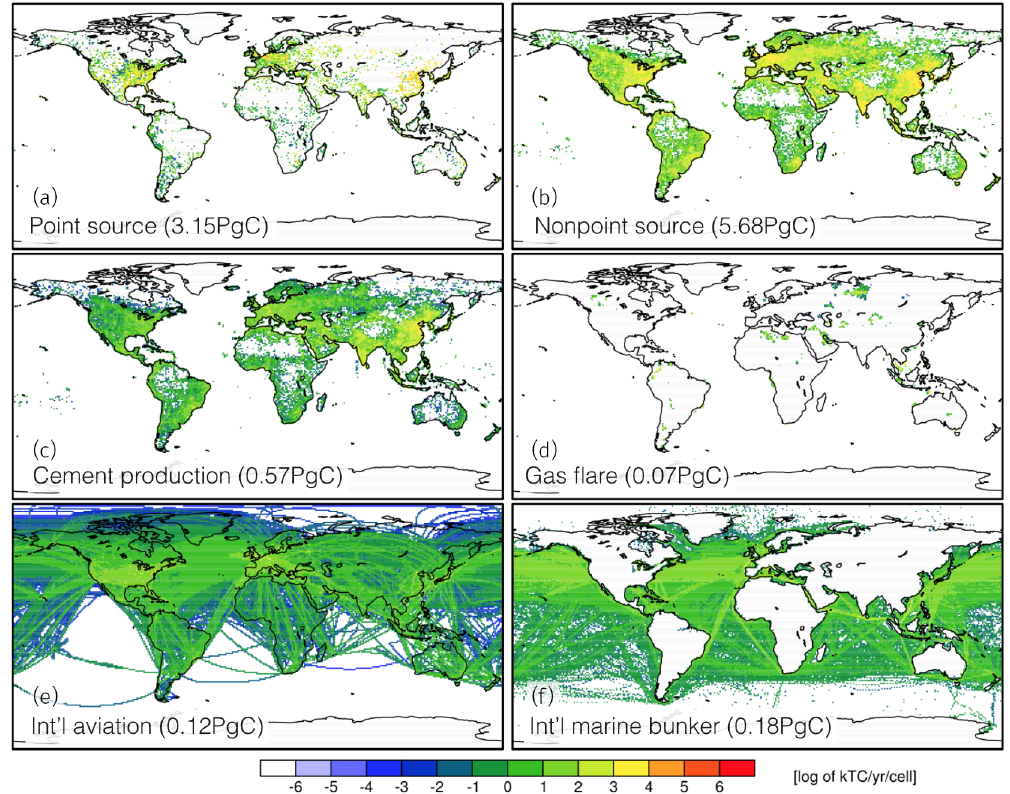
Figure 5. The 2013 global distributions of ODIAC fossil fuel emissions by emissions type. The panels show emissions from (from top to the right, then down) point source, nonpoint source, cement production, gas flaring, international aviation, and international shipping. The values in the figures are given in the unit of log of thousand tons of carbon per year per cell (1 × 1 ◦ ). The numbers in the brackets are the total for the category emissions in the unit of PgC (total 2013 emissions in ODIAC2016 was